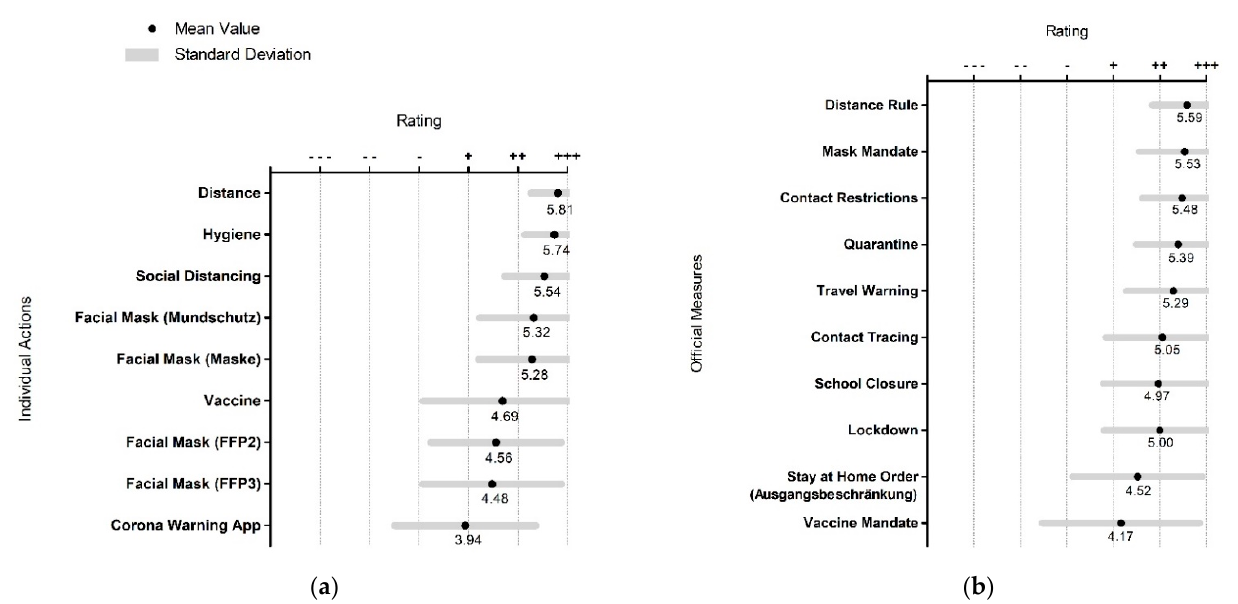
Figure 3. ( a ) Importance of individual actions to prevent SARS-CoV-2 infections; ( b ) importance of official measures for containing the coronavirus pandemic in Germany; (ranging from ( −−− ) for completely unimportant to (+++) for very important).